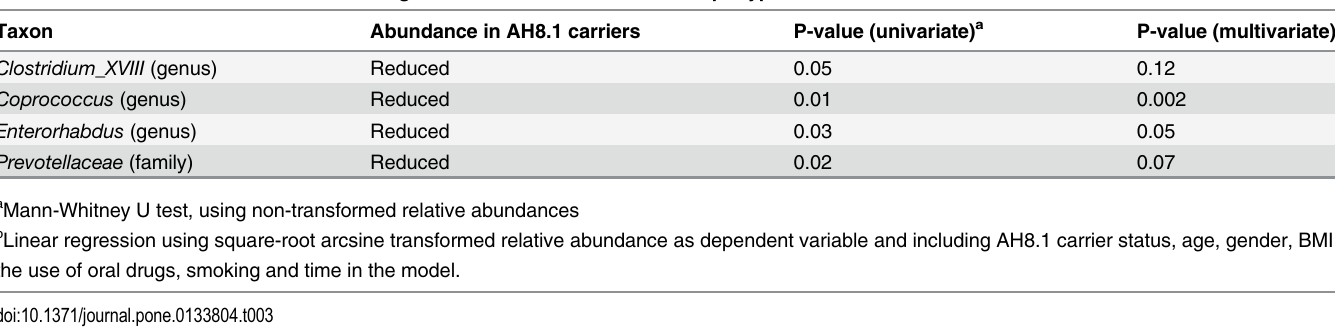
Table 3. Bacterial taxa associated with being a carrier of the ancestral HLA haplotype